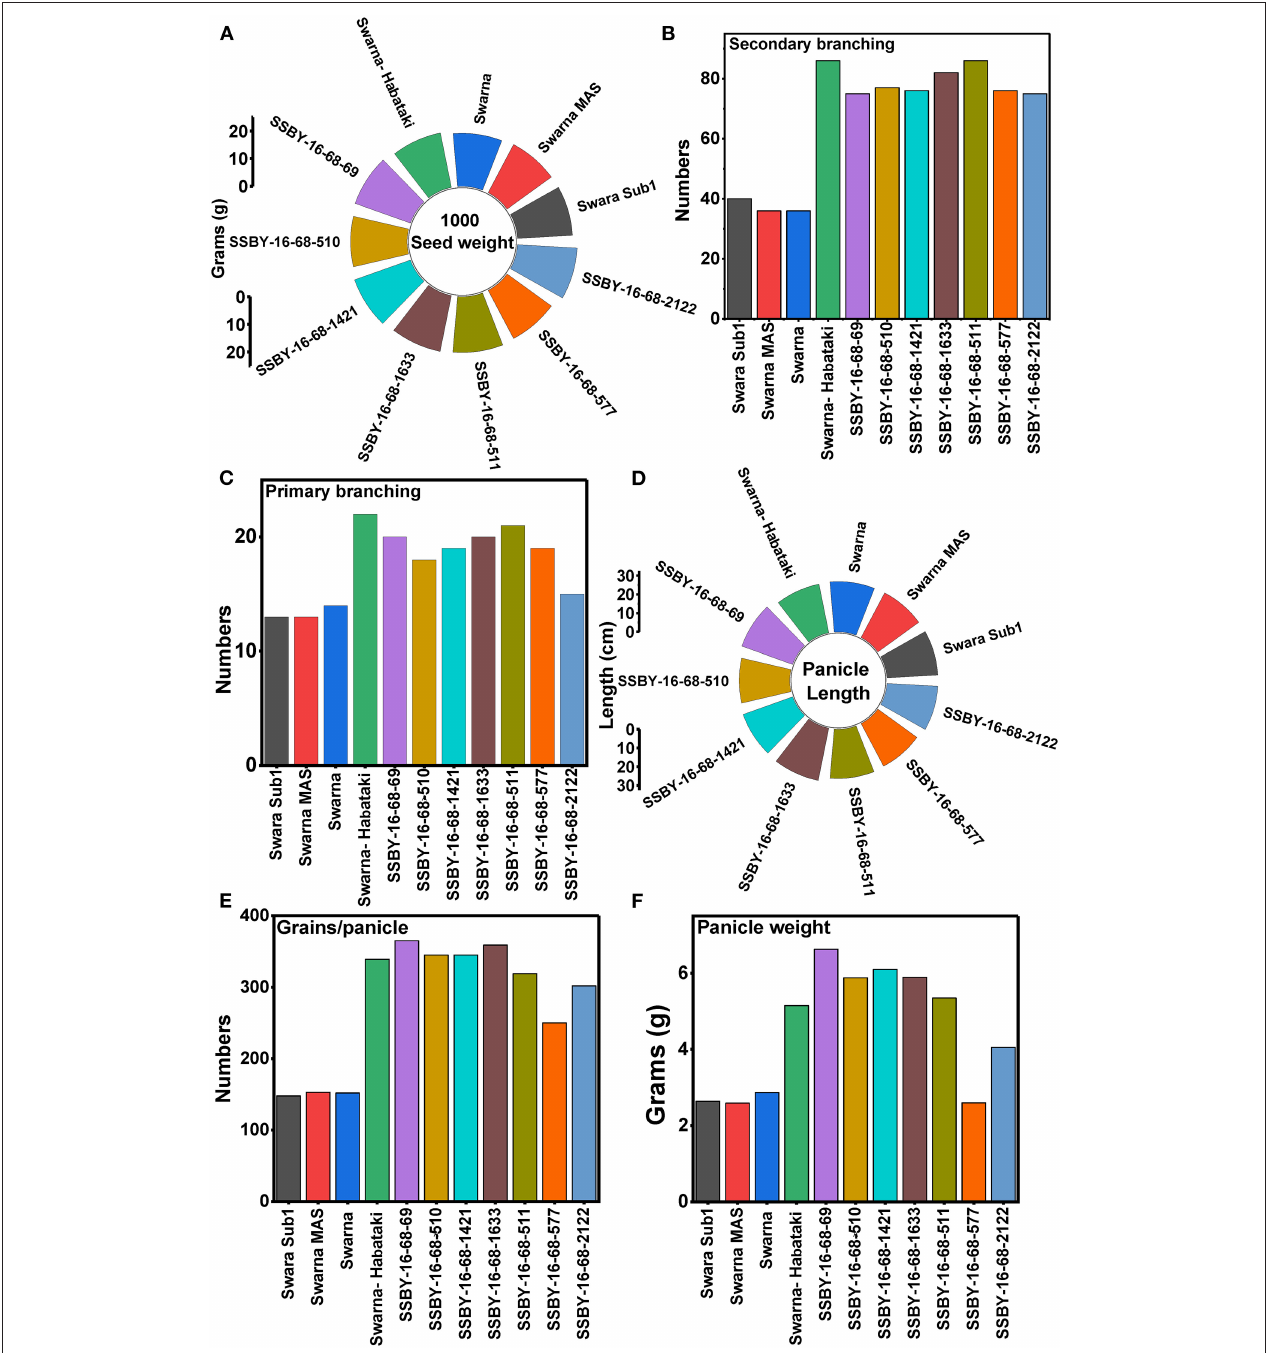
FIGURE 9 | Agro-morphologic and yield parameters of the progenies and parental lines (A) 1,000-seed weight; (B) secondary branching; (C) primary branching; (D) panicle length; (E) grains/panicle; and (F) panicle weight.